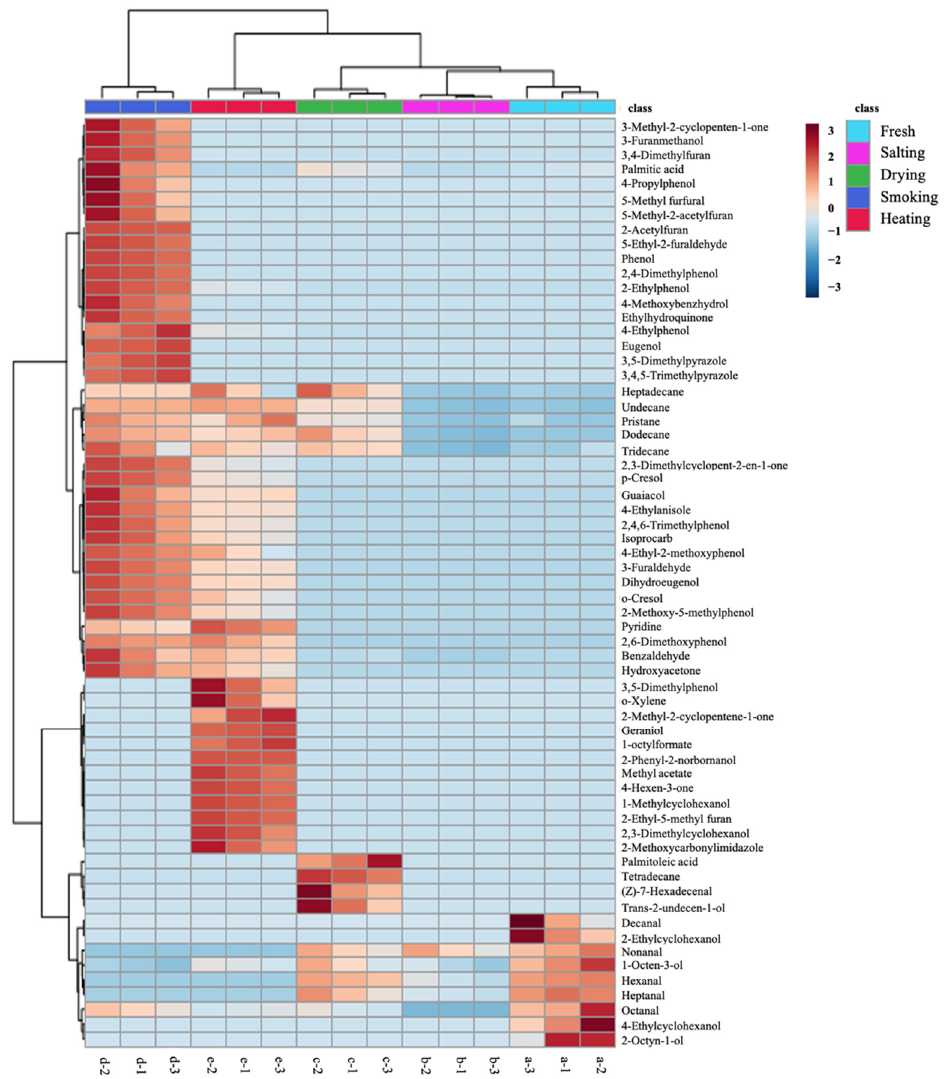
Figure 2. The heat map and clustering results of 63 volatile compounds in different production steps. Color shading from red to blue indicates abundances of compounds from high to low.